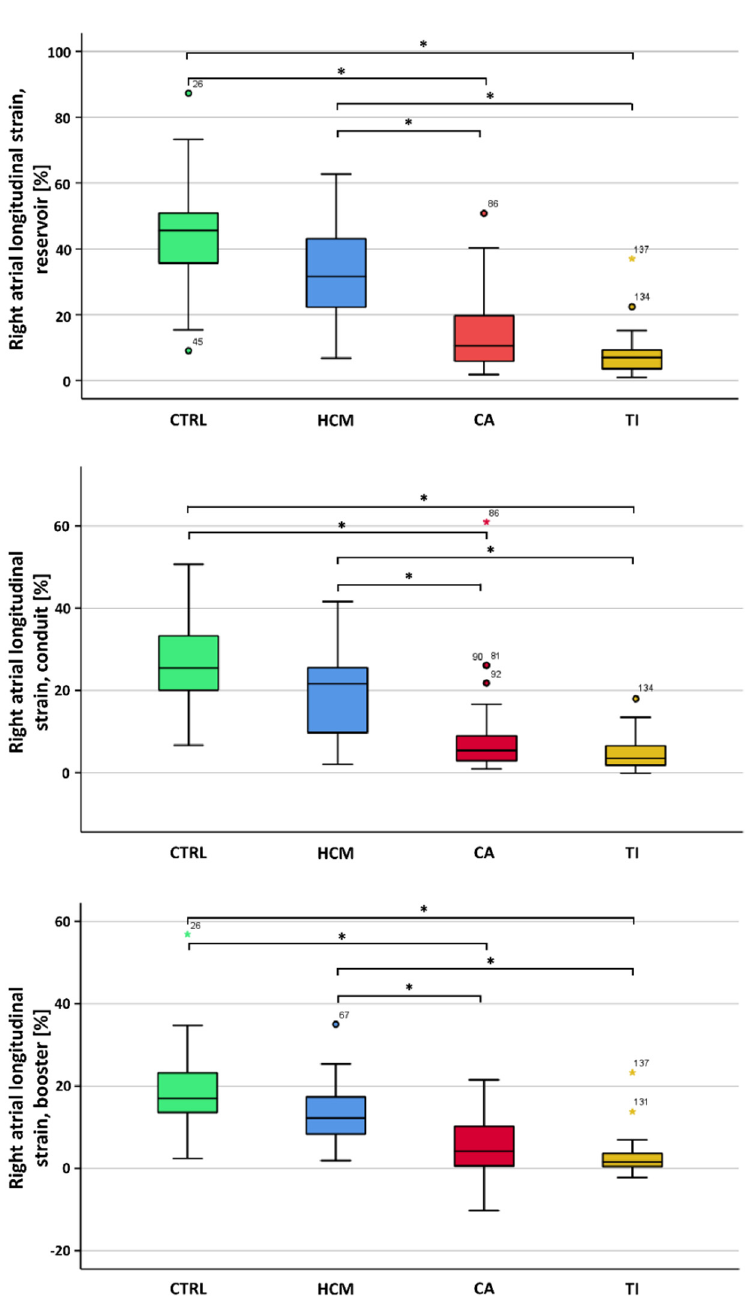
Figure 2. Box plots of right atrial longitudinal strain for functional phases of reservoir, conduit and booster between CTRL subjects and HCM, CA and TR patients. * Statistical significance.